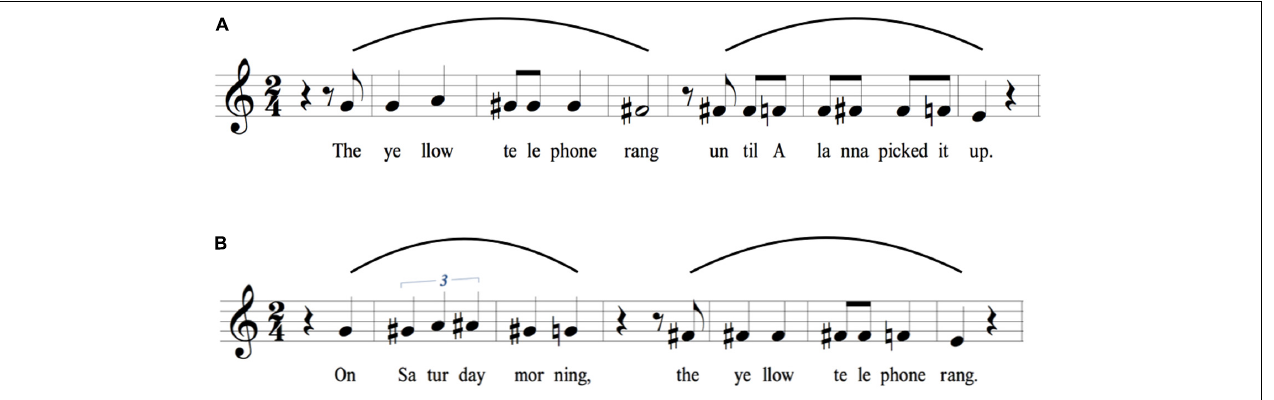
FIGURE 5 | Melodic contours for long sentences consisting of two intonational phrases, characterized by two melodic arches. Both sentences in this figure contain phrases based on items found in Figures 2 – 4 . The sentence in (A) combines sentence B in Figure 4 and sentence B in Figure 3 . The sentence in (B) combines sentence C in Figure 2 and sentence B in Figure 4 . The melodic contour of a long sentence consisting of two intermediate phrases shows two arched patterns, similar to those in the sentences presented in Figure 4 . These sentences provide further evidence of contour reversals, melodic arches, suspensions of declination, and terminal drops. See text for details.